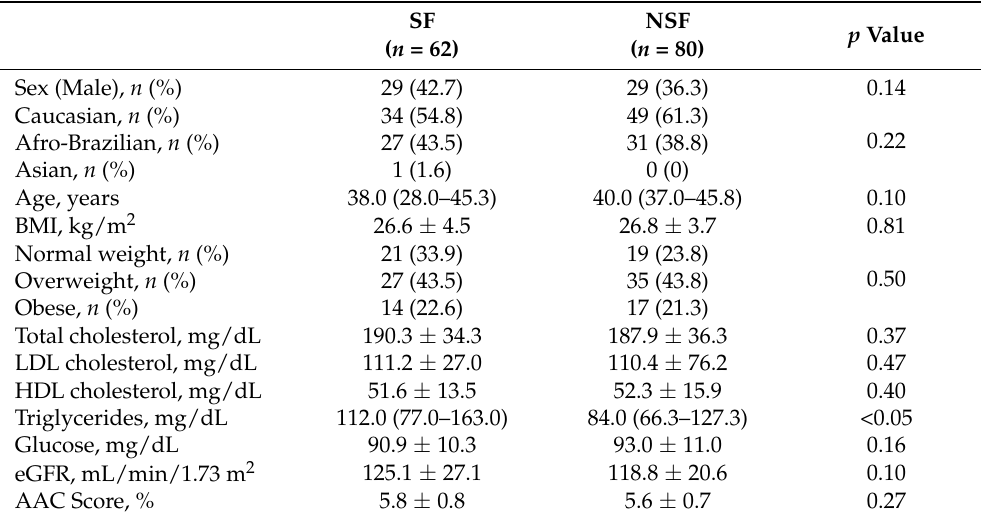
Table 1. Demographic characteristics, laboratory parameters, and AAC score (%) of SF and